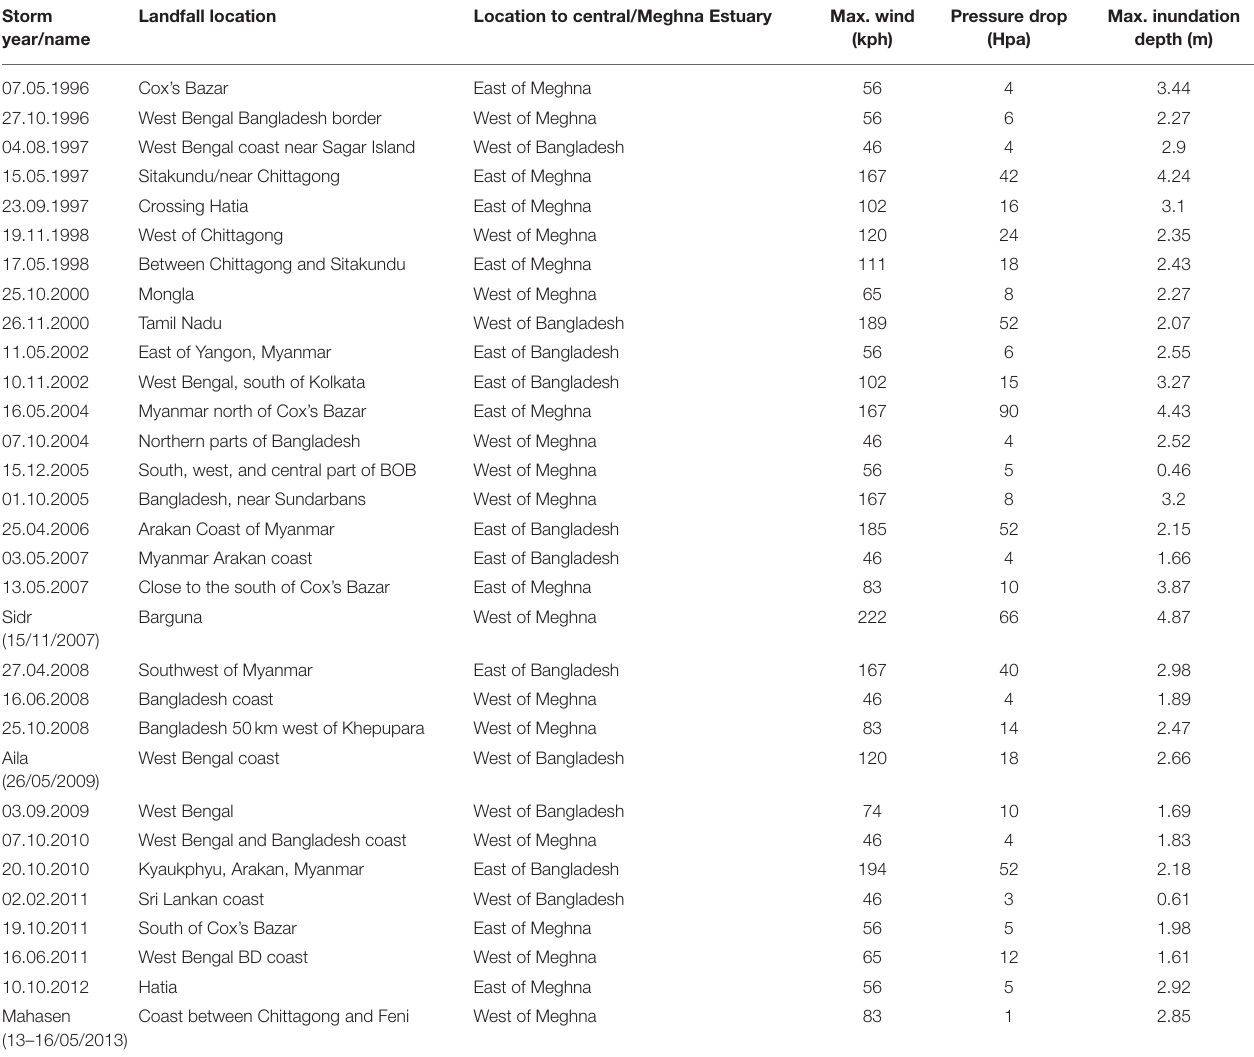
TABLE 1 | The inundation database with cyclone date, landfall location, intensity, and simulated maximum inundation. Storm